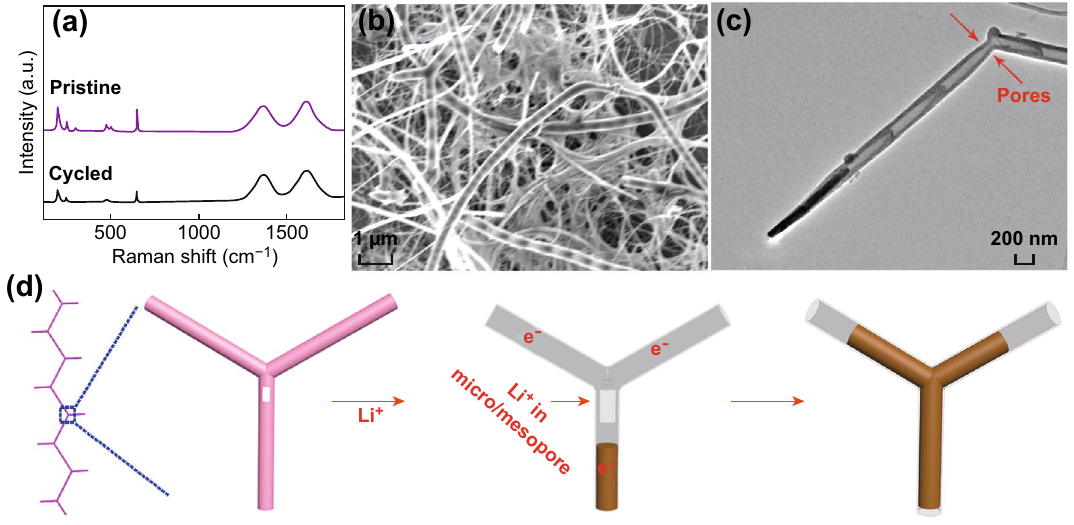
Fig. 4 a Raman spectra of the pristine and cycled electrode. b SEM and c TEM images of Co 9 S 8 @NBNT after 200 cycles. d Schematic illustra‑ tion of electron transfer and lithium‑ion storage in the Co 9 S 8 @NBNT